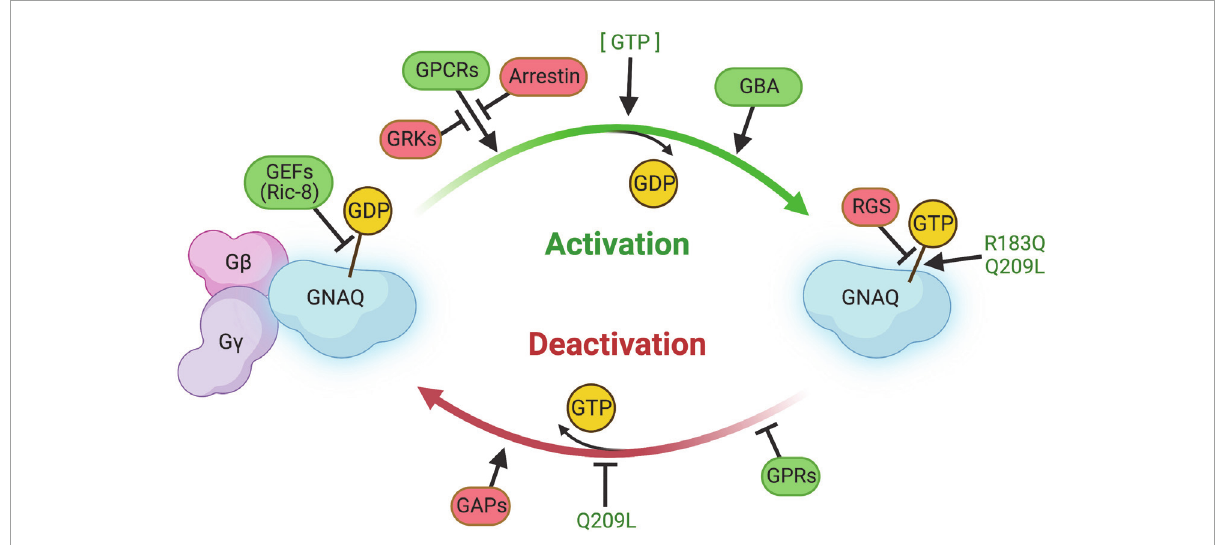
FIGURE5 Summary of regulators of GNAQ signaling. GEFs, GPCRs, GBA proteins, and GPRs promote GNAQ-GTP “on” signaling and/or delay GTP hydrolysis. Arrestin, GRKs, RGS, and GAPS slow activation of GNAQ, stimulate GTP hydrolysis, and/or stabilize the GNAQ-G βγ complex. The p.R183Q and p.Q209L strongly stabilize GNAQ-GTP binding and the p.Q209L mutation impairs intrinsic GNAQ GTPase activity. Image created using